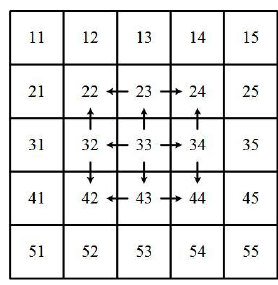
Figure 3. Weighted adjustment sequence.